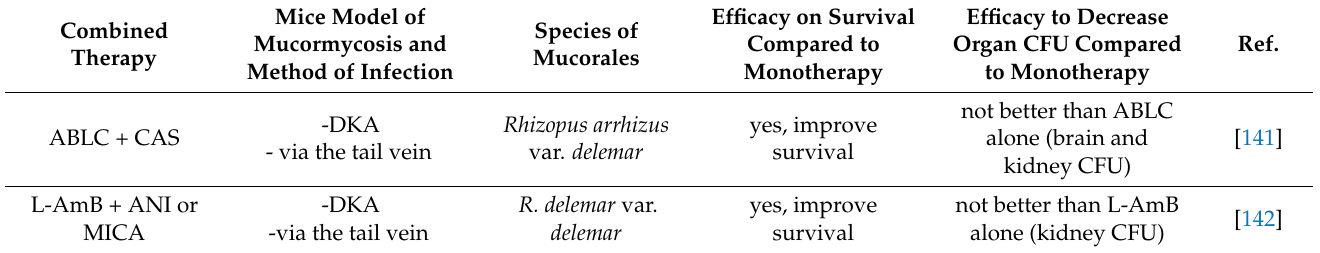
Table 1. Combination therapy in mice models of disseminated mucormycosis. ABLC: